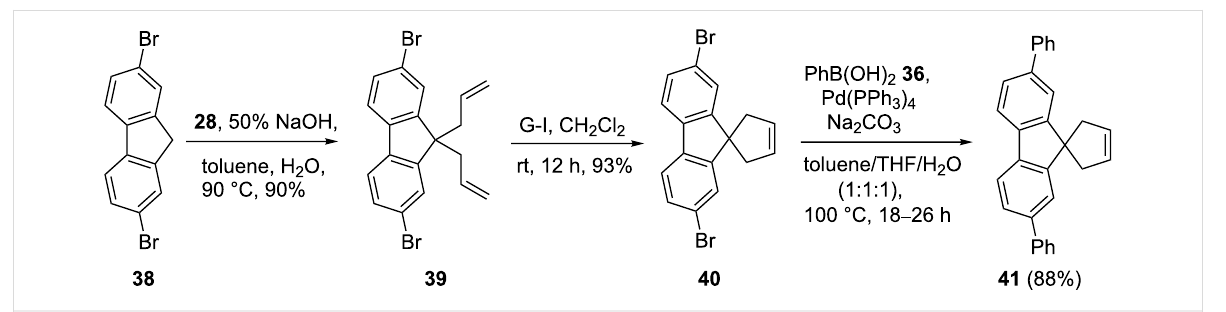
Scheme 6: Synthesis of spirofluorene derivatives via RCM and SM coupling